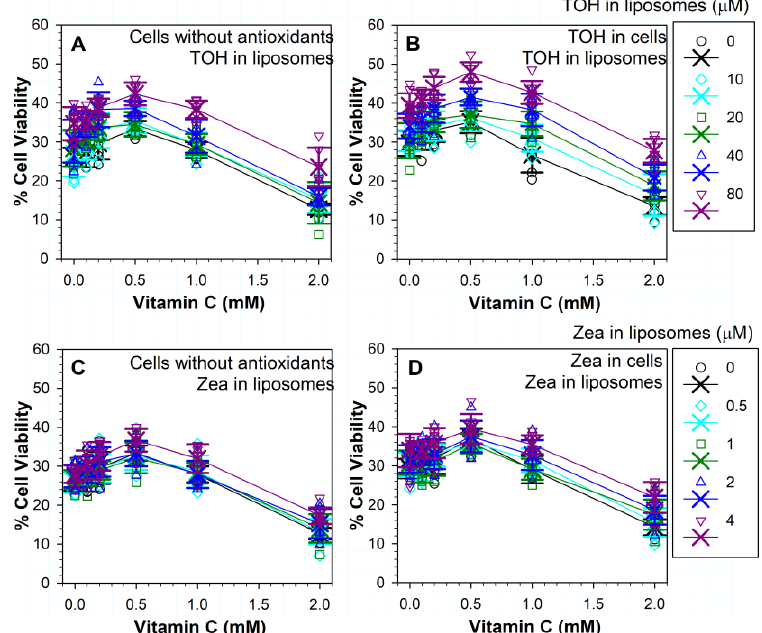
Figure 8. Effects of different concentrations of vitamin C in combination with α -tocopherol (TOH) ( A , B ) or zeaxanthin (Zea) ( C , D ) on the viability of ARPE-19 cells after 1 h exposure to visible light in the presence of EYPC liposomes containing 0.5 mM ATR and indicated concentrations of α -tocopherol or zeaxanthin. Cells were either not pre-treated with antioxidants ( A , C ) or supplemented with α - tocopherol ( B ) or zeaxanthin ( D ). Cell viability was measured by MTT assay 24 h after the exposure. The symbols represent data from individual experiments, crosses represent the means, while the error bars show SDs. The individual data points from experiments with no antioxidants in liposomes are shown only in Figure 3; N for experiments with antioxidants in liposomes and without ascorbate was 8; N for for experiments in the presence of ascorbate was 6). Other experimental conditions as in Figure